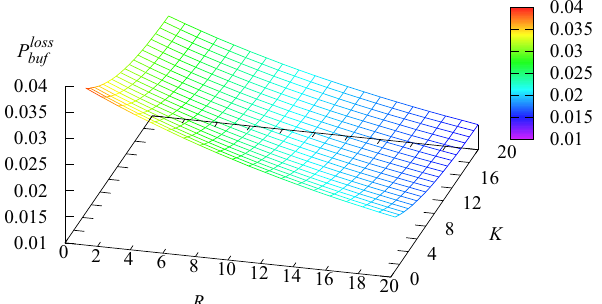
Figure 17. Dependence of the loss probability P loss on K and R .